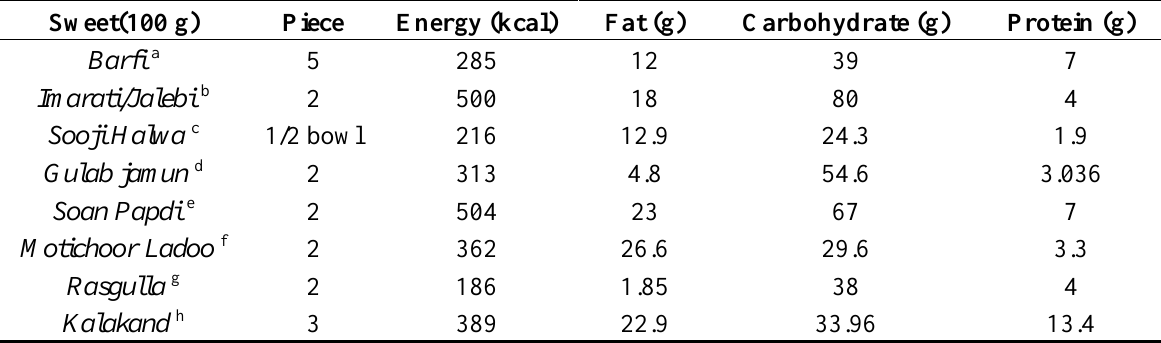
Table 5. Calorific value of some of the commonly consumed North Indian sweets. Sweet(100 g)